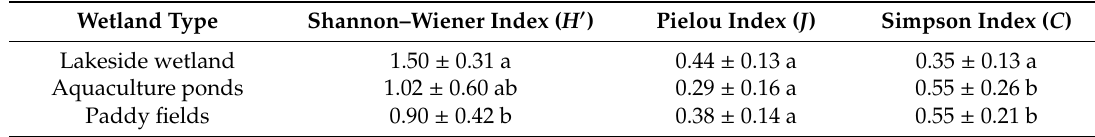
Table 4. Species diversity of waterbirds in di ff erent types of